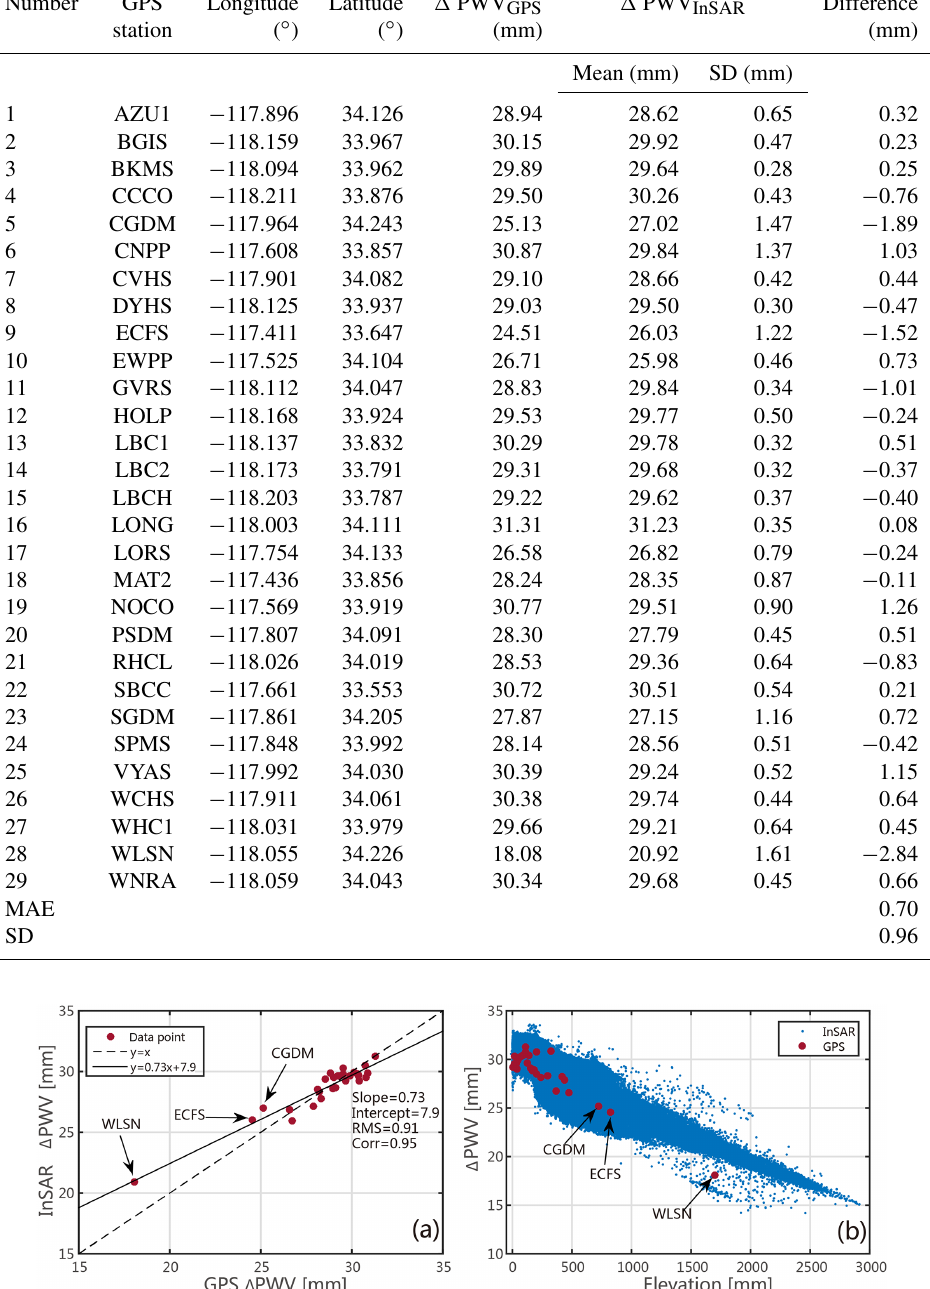
Figure 8. (a) GPS (cid:49) PWV plotted against the calibrated (cid:49) PWV from the interferogram (master image from 16 August 2008, slave image from 25 October 2008). The slope of the solid line in the figure is 0.73, large differences were found on stations CGDM, ECFS and WLSN. (b) GPS (red) and InSAR (blue) (cid:49) PWV plotted as a function of elevation. Black arrows indicate the locations of GPS sites CGDM, ECFS and